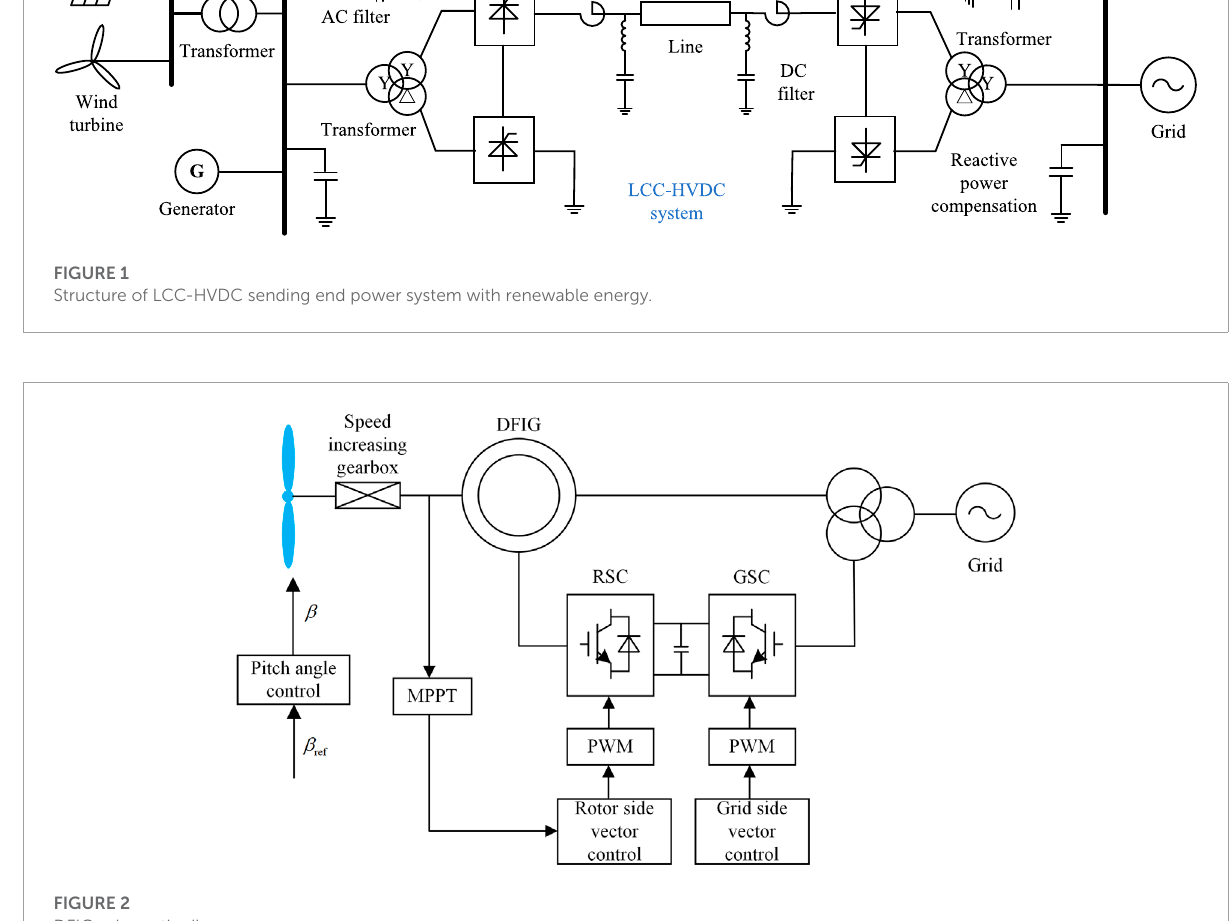
FIGURE 2 DFIG schematic